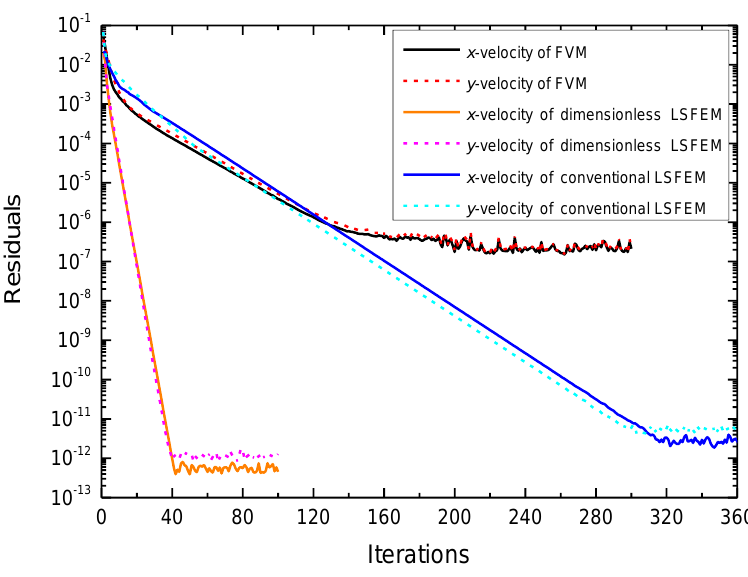
Figure 6. Comparison of convergence curves.